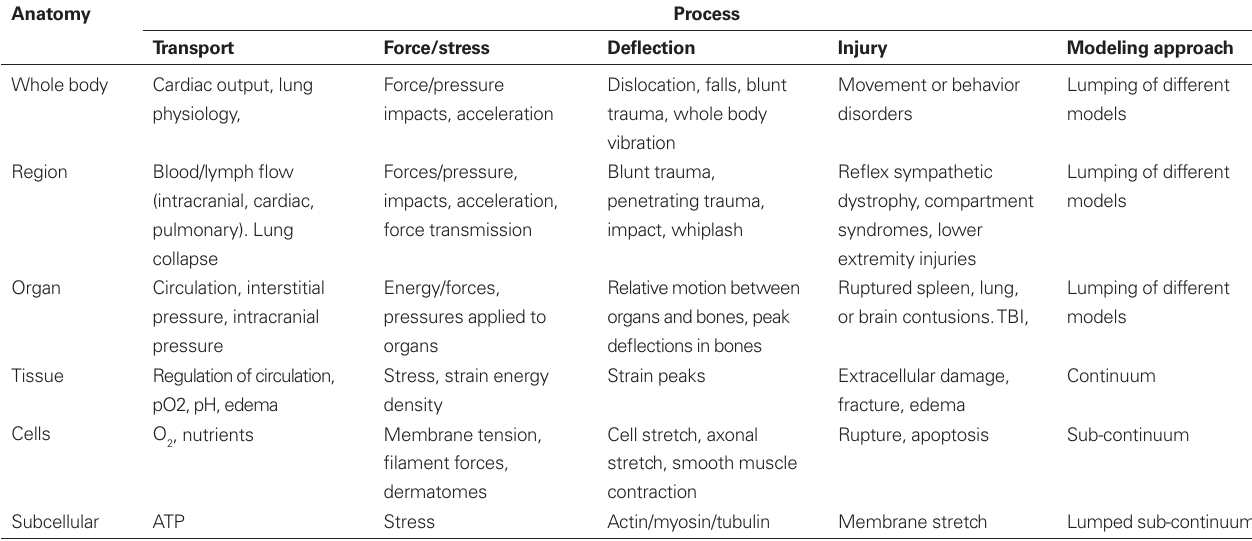
Table 1 | Anatomy and processes for computational modeling.